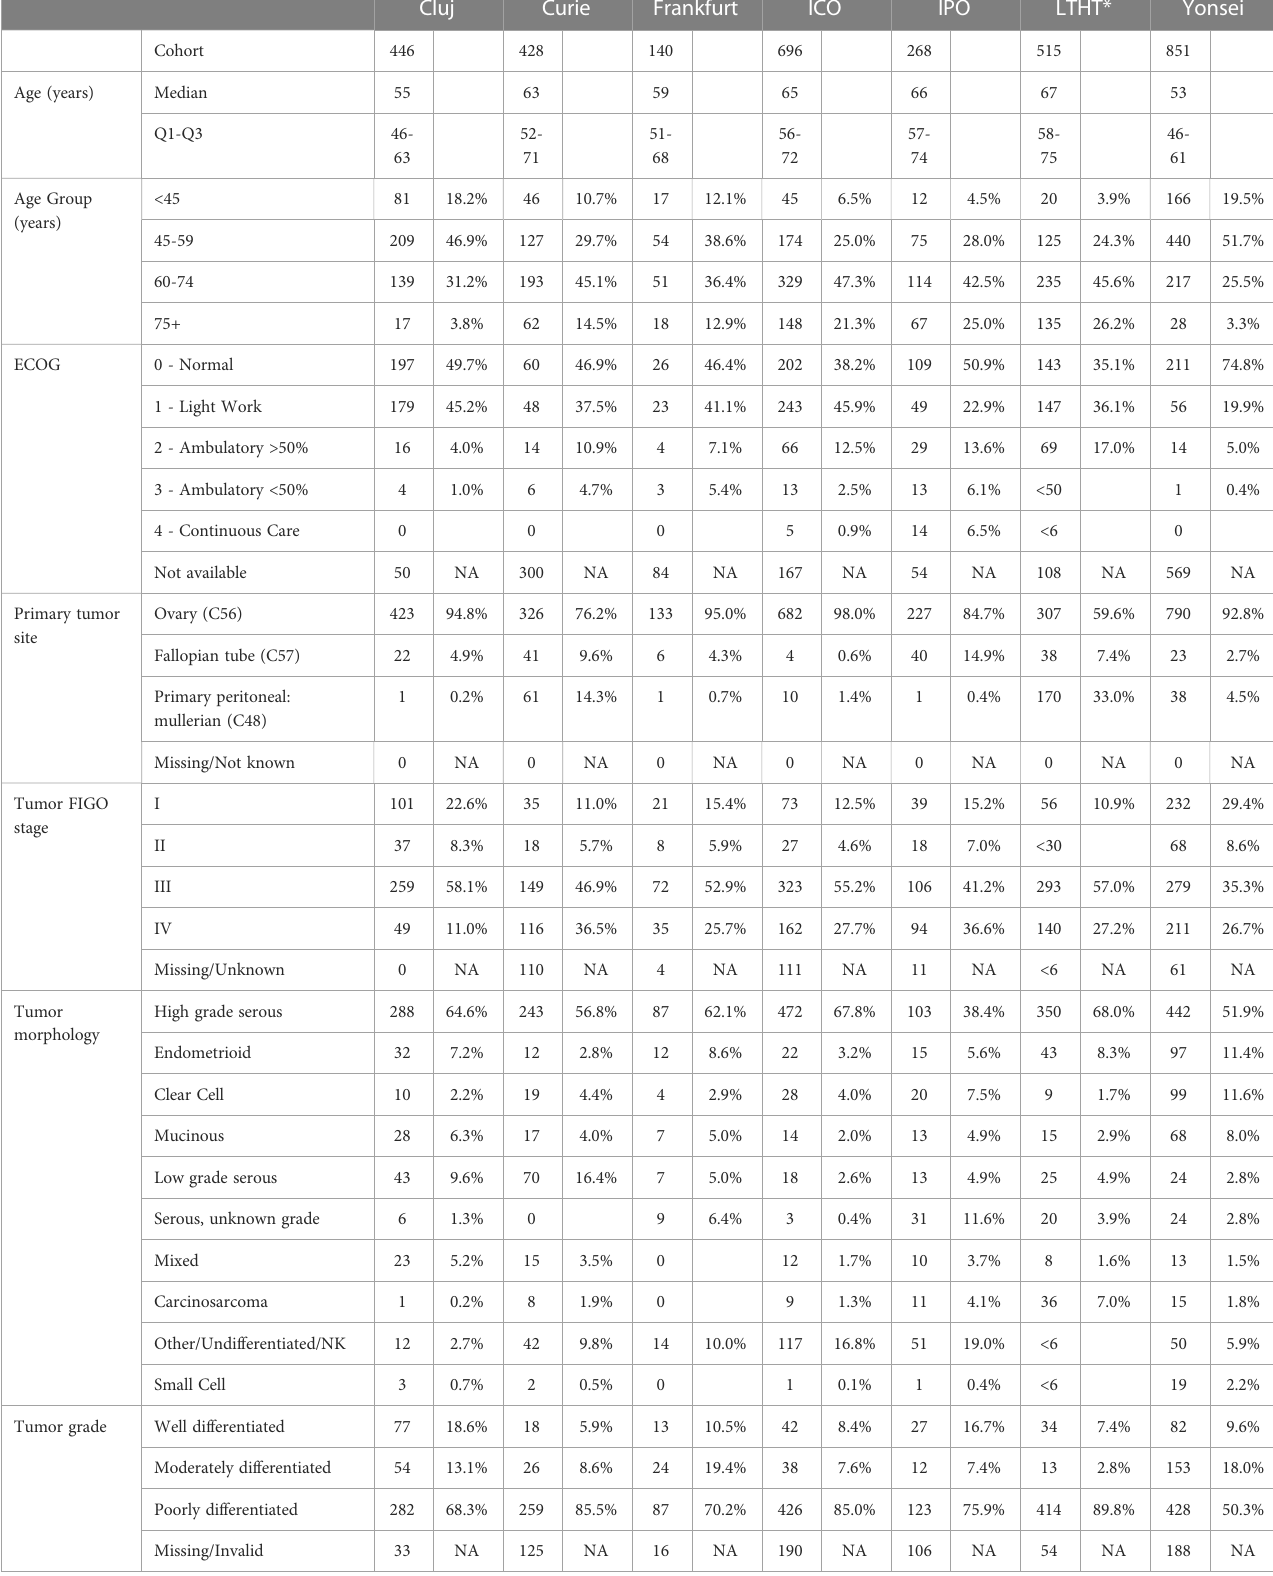
TABLE 1 Characteristics of ovarian cancer patients treated at 7 participating study sites between 2012 and